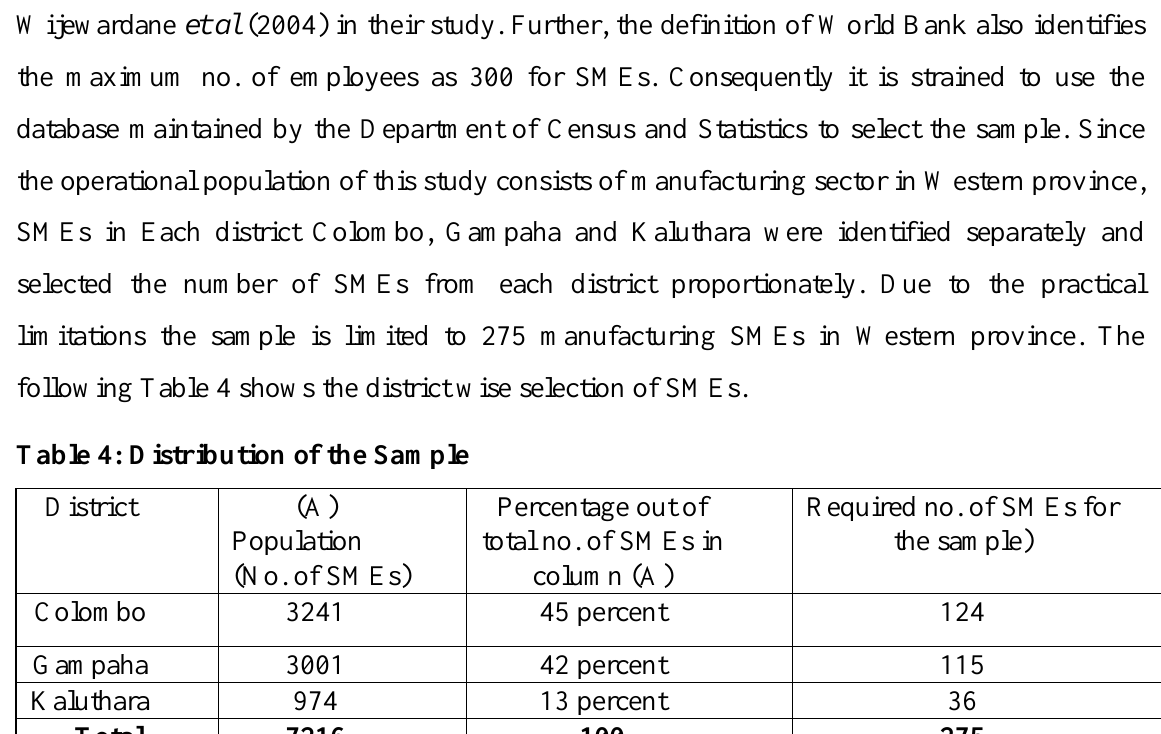
Percentage out of total no. of SMEs in column (A)